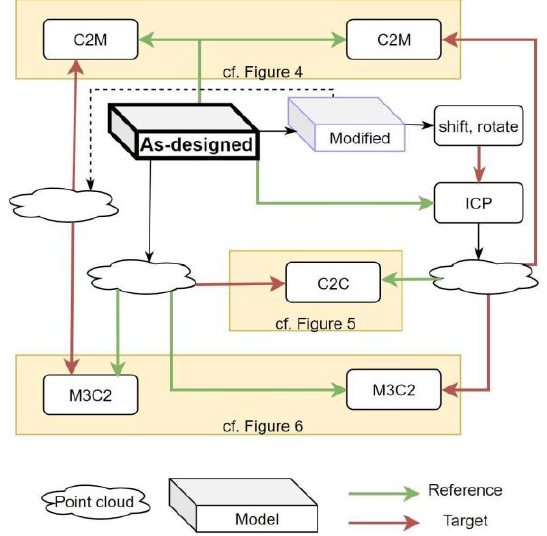
Figure 2 . Our strategy for analyzing various deviation measurement approaches.